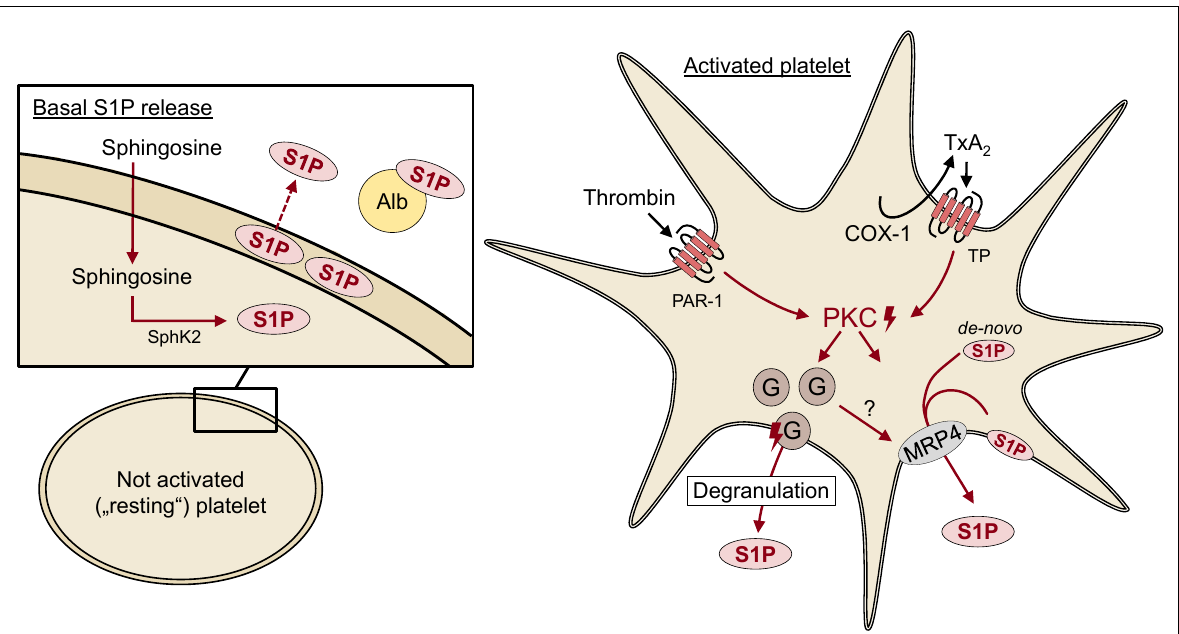
Figure 2. Release of S1P from resting and activated platelets. Platelets rapidly take up sphingosine from the serum and convert it into S1P. S1P is then stored within the platelet membrane and is released at a basal level in a calcium-dependent manner. After the activation of platelets with various agonists, such as thrombin or TxA 2 , S1P is released in bulk via de novo synthesis or from intracellular reservoirs in granules. The transporter MRP4, which is located mainly in the plasma membrane in activated platelets, has been shown to be capable of active S1P transmembrane transport. While both processes of degranulation and S1P secretion are linked to PKC, it is currently unclear how MRP4 is involved in the granule-dependent S1P release or if the secretion of S1P by MRP4 occurs independently. In addition, other mechanisms have been suggested to be involved in platelet S1P release, including the transporter Mfsd2b. For references, see Section 2.2. Alb, albumin; COX-1, cyclooxygenase 1; G, granules; MRP4, multidrug resistance protein 4; PAR-1, protease-activated receptor 1; PKC, protein kinase C; S1P, sphingosine-1-phosphate; SphK2, sphingosine kinase 2; TP, thromboxane receptor; TxA 2 , thromboxane A 2 ; ?, unclear to date.